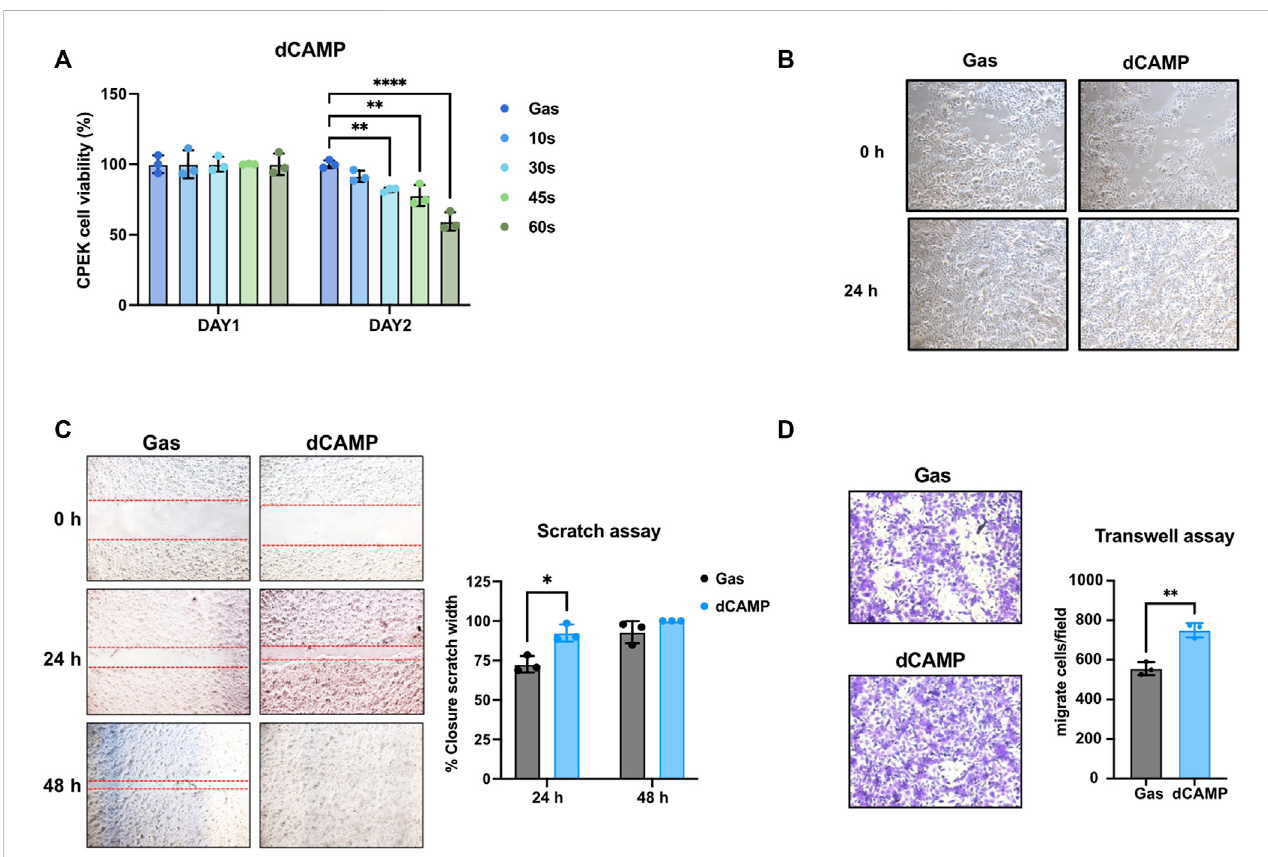
FIGURE 3 dCAMPtreatmentshowedpreferableactivitiestoaugmentcellmigrationandinvasionabilitiesincaninekeratinocytes ’ woundhealing. (A) Cellviabilityof CPEK cells at 24 h and 48 h after being directly treated with various exposure times of CAMP or gas. (B) Cell morphology of CPEK cell before and after treatment with 30-s dCAMP. (C) Scratch assay shows the signi fi cantly higher wound closure rate in 30-s dCAMP-treated CPEK cells, than gas. (D) Transwell assay shows the positive effects of 30-s dCAMP on the wound-healing process by promoting CPEK cell migration and invasion. Data are presented as mean ± standard error, * p < 0.05, ** p < 0.01, and **** p < 0.001 compared with the gas-treated group.